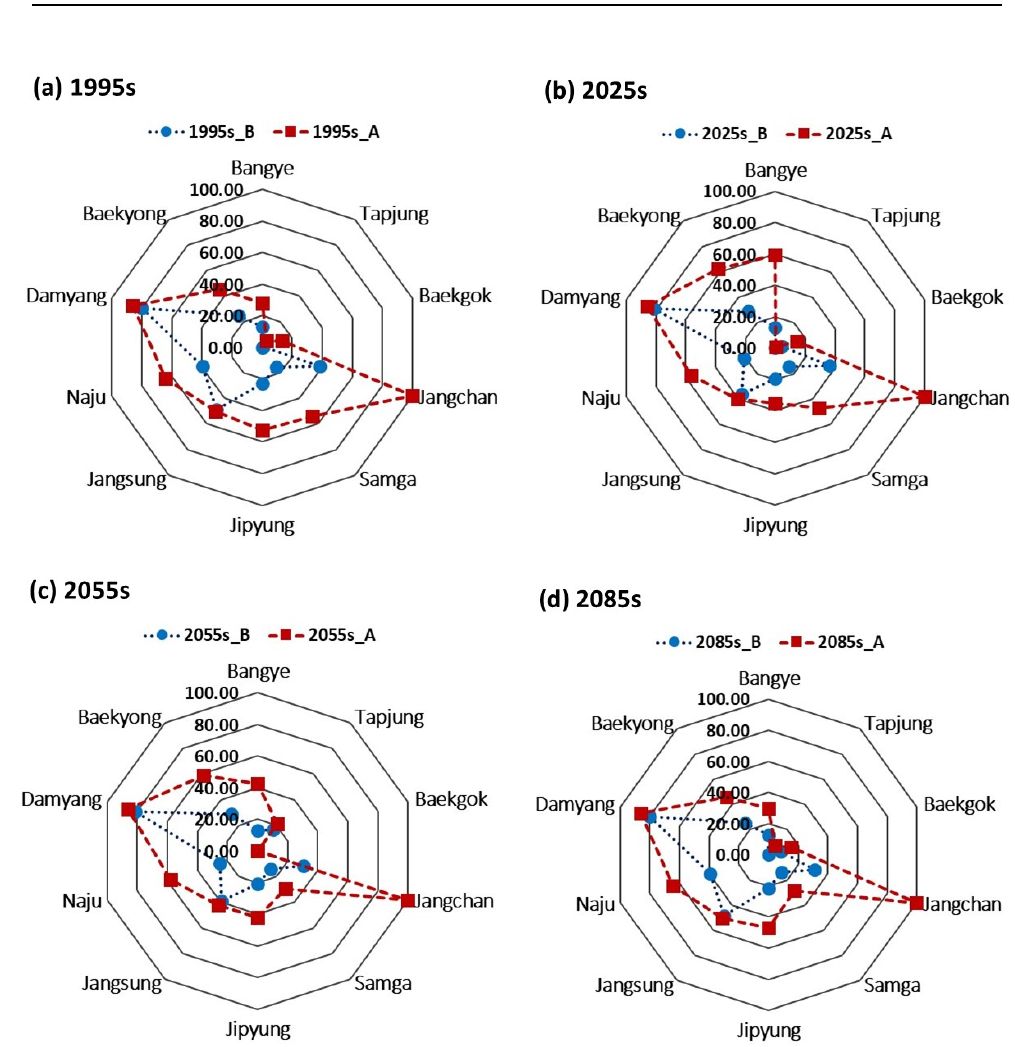
Figure 3. Comparison of flood control ratio before and after dam heightening of for ten reservoirs under climate change. B stands for before dam heightening and A stands for after dam.